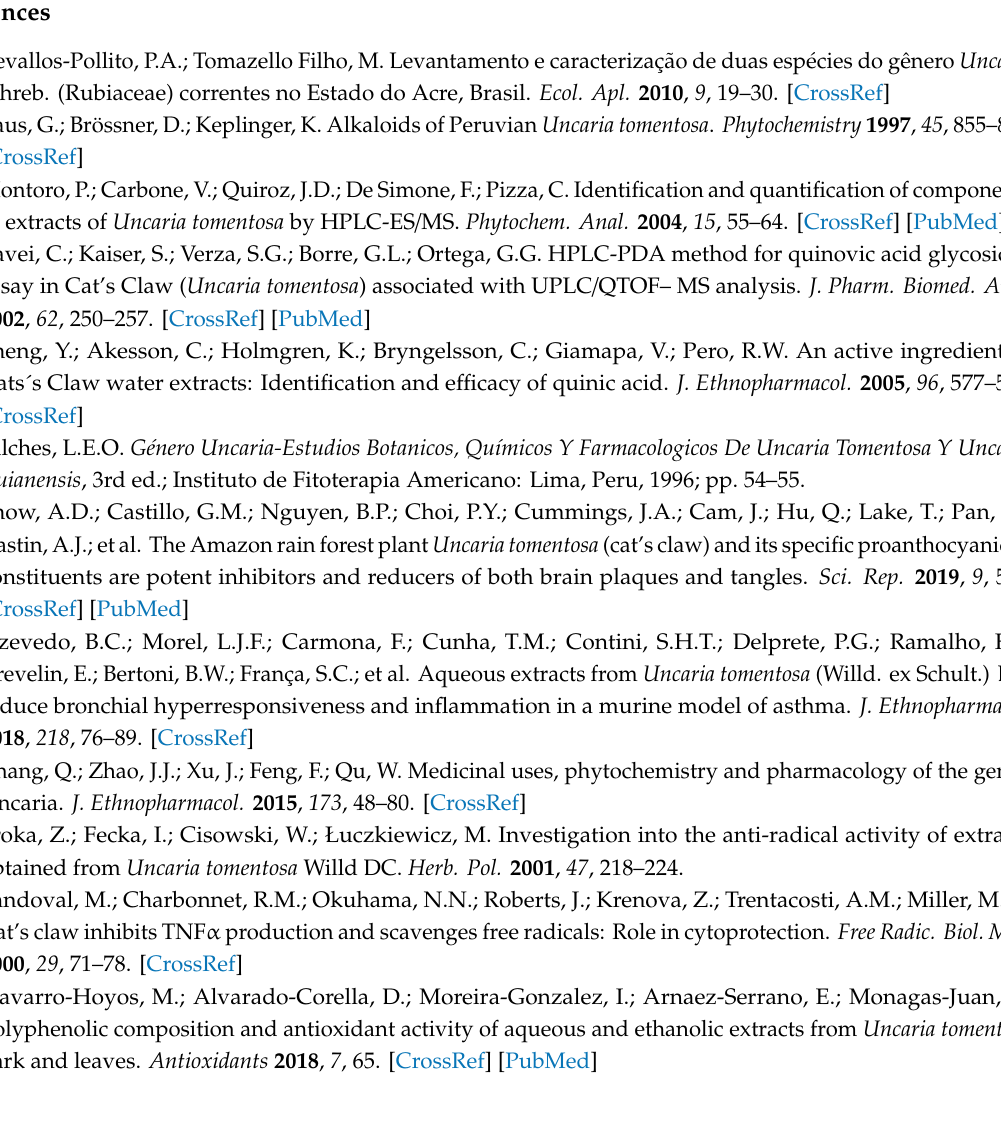
Figure S3. 1 H-NMR spectrum (expanded view) of isorhynchophylline (600 MHz, DMSO-d 6 ), Figure S4. 13 C NMR (150 MHz, DMSO-d 6 ) spectrum of isorhynchophylline, Table S1. 13 C-NMR spectral data of isorhynchophylline isolated from U. tomentosa (150 MHz, DMSO-d 6